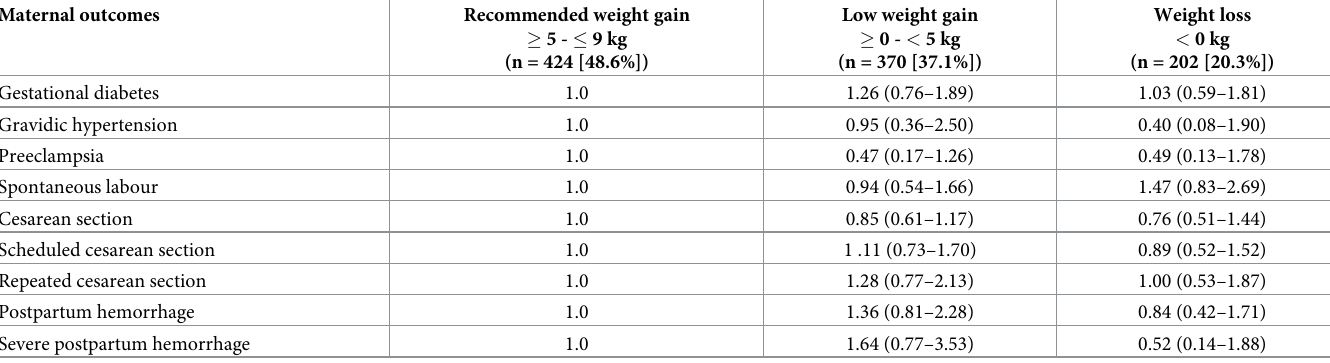
Table 2. Maternal outcomes associated with gestational weight gain or loss in women with class II obesity†. Maternal outcomes